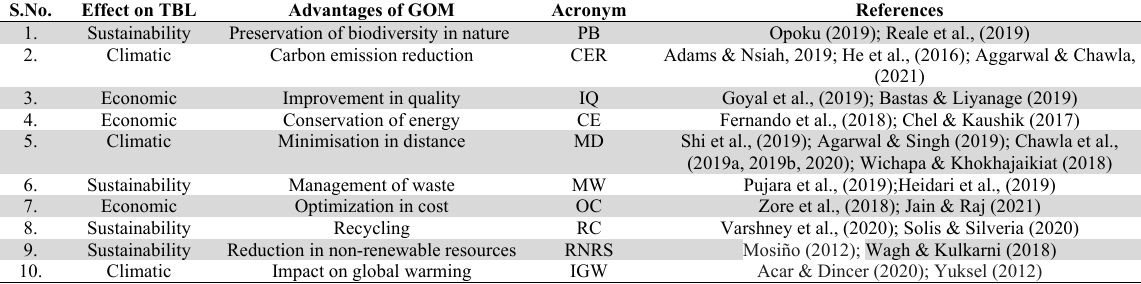
Parameters leading to Conservation of